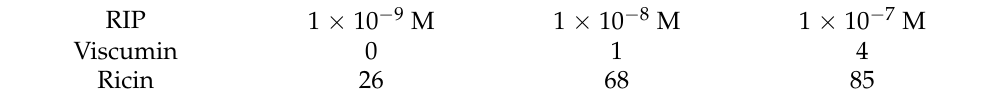
Table 2. The fraction of ribosomes inactivated by RTA and MLA (in %) *.